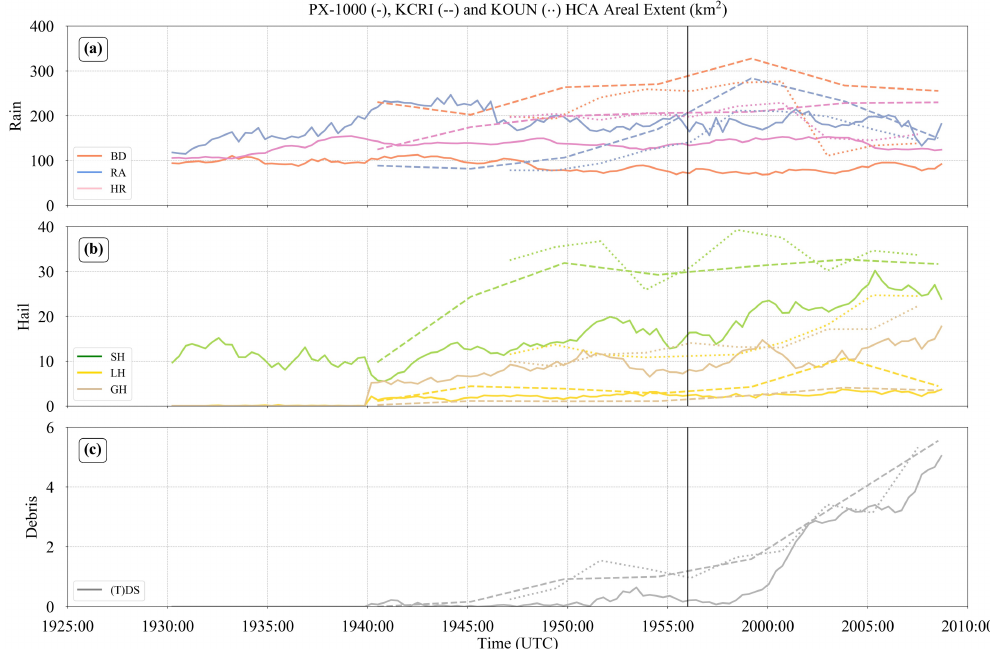
Figure 5. Time series in HCA areal extent for ( a ) rain (BD, RA, and HR), ( b ) hail (SH, LH, and GH), and ( c ) debris ((T)DS) classes for PX-1000 (solid line), KCRI (dashed line), and KOUN (dotted line). The elevations for KCRI (2.4 ◦ ) and KOUN (3.0 ◦ ) are chosen to be closest in beam height to PX-1000 (2.6 ◦ ). The solid black vertical line denotes the time of tornadogenesis at ∼ 1956